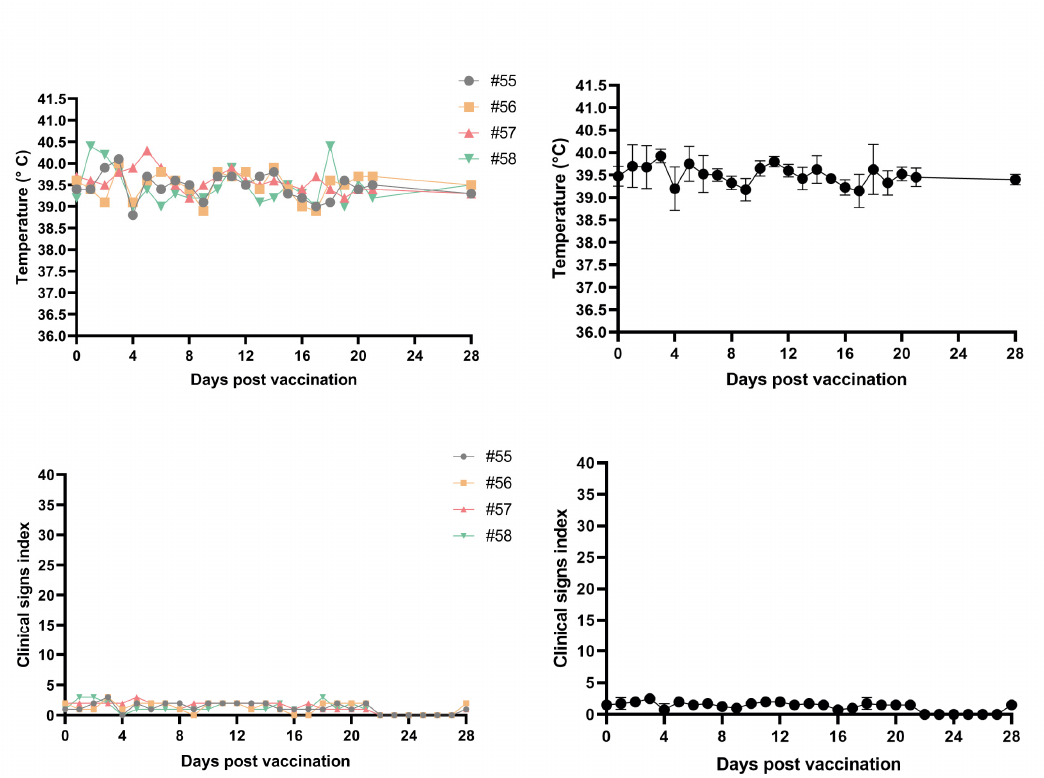
Figure 4. Clinical safety profile study of pigs inoculated with the vaccine prototype Arm- ∆ CD2v- ∆ A238L. ( A ) Individual (right) or average (left) daily temperatures of pigs receiving a 10 2 TCID50 dose of the Arm- Δ CD2v- Δ A238L during 28 days after vaccination. ( B ) Clinical scores of individual pigs ( right ) or average ( left ) receiving a 10 2 TCID50 dose of the Arm- Δ CD2v- Δ A238L during 28 days after vaccination. Scores were determined based on several parameters, including fever, inappetence, recumbency, skin hemorrhage, hemorrhagic areas on ears and body, joint swelling, labored breathing and/or coughing, ocular discharge, diarrhea, blood in urine and vomiting (see Table S2).